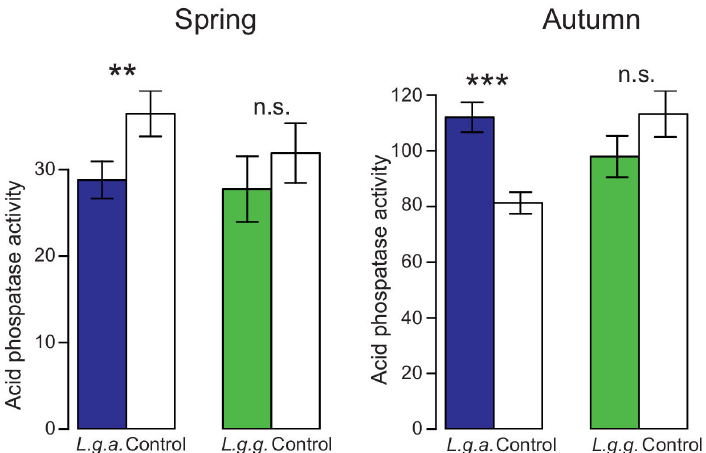
Figure 9. Acid phosphatase activity (nmol MUB released per g soil and h) in Lamium galeobdolon subsp. argentatum plots, Lamium galeobdolon subsp. galeobdolon plots and corresponding control plots in both spring and autumn. Mean values ± s.e. are shown, n = 18. Differences were tested using paired t -tests; ** p < 0.01, *** p < 0.001, n.s. not significant).